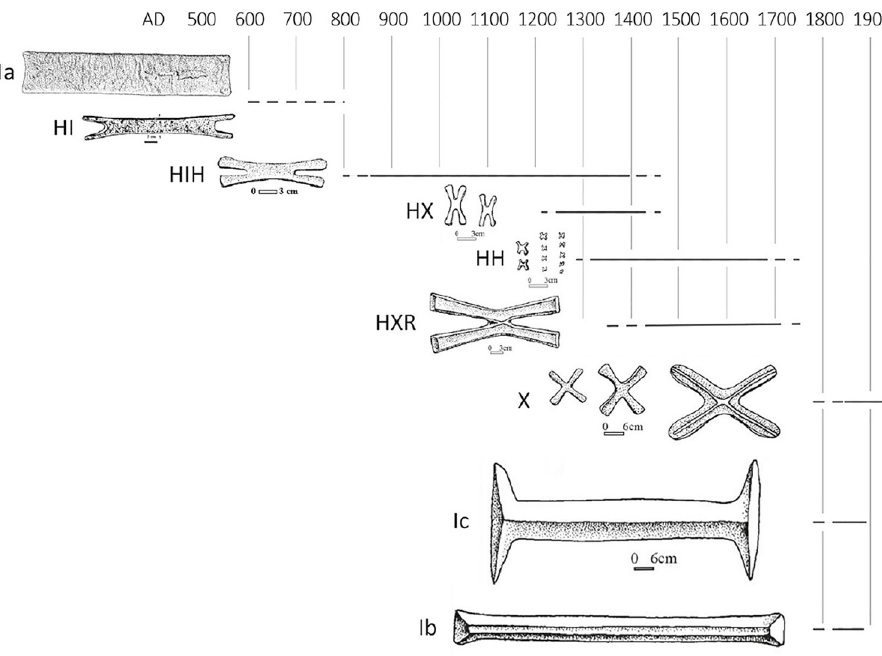
Fig 2. “Ia” (rectangular and fishtail) and croisette ingot typology. (Reproduced from Rademakers et al. [24], Fig